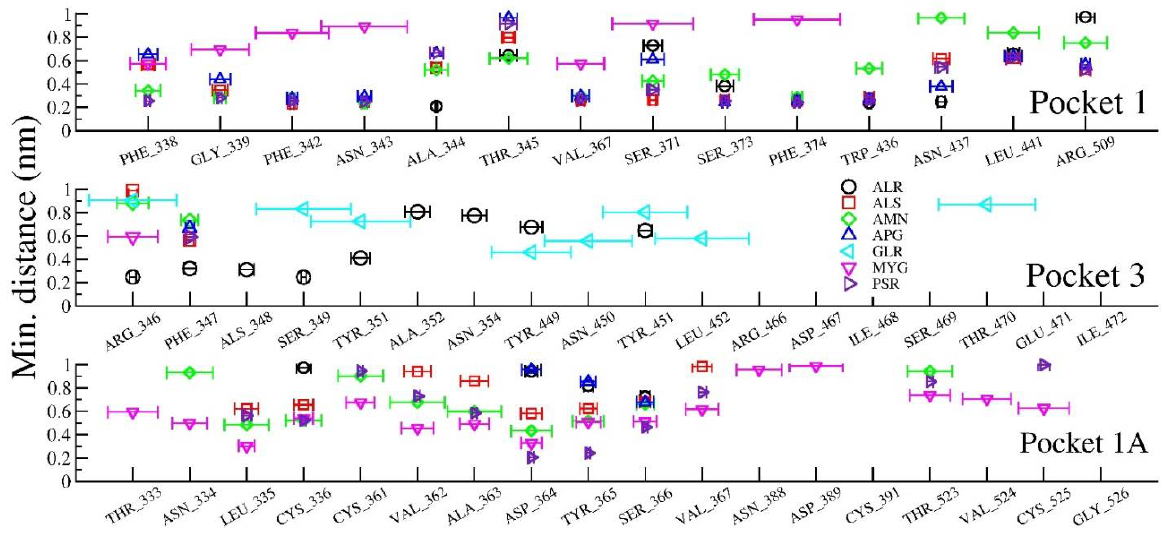
Figure 11. Minimum distance between amino acids of the protein and selected ligands.